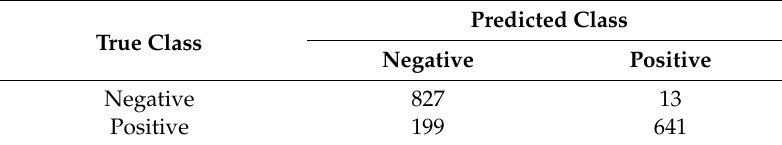
Table 13. Deep FC2 features and KNN classifier.